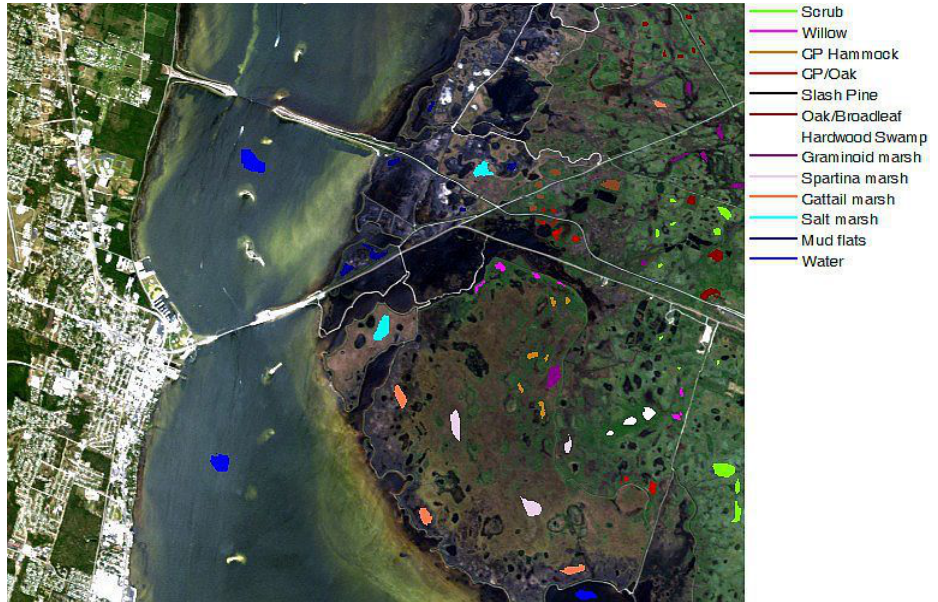
Fig.2 The overlaid image of training sets of AVIRIS